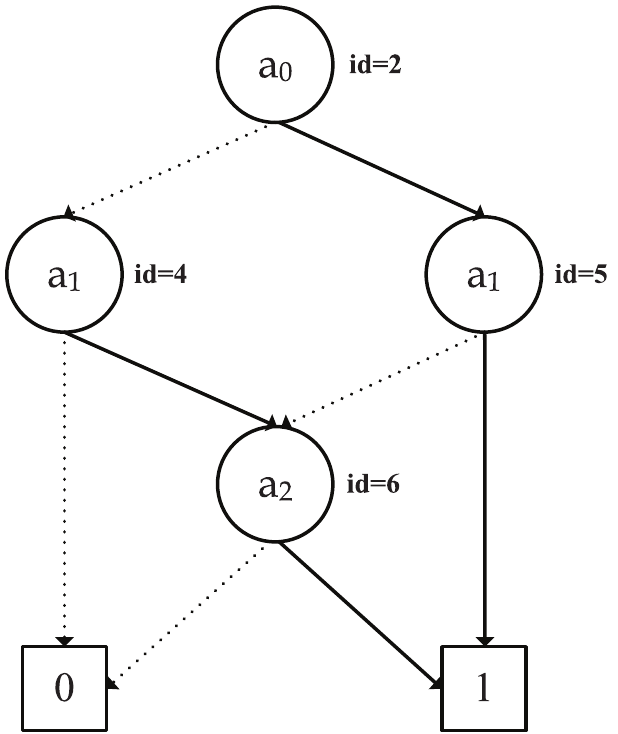
Fig 1. An OBDD access structure depicting the f ( a 0 , a 1 , a 2 ) = a 0 . a 1 + a 0 . a 2 + a 1 . a 2 access formula with variable ordering as: a 0 < a 1 < a 2 . The solid arrows represent the edges leading to the nodes’ high ( v ) child nodes and the dotted arrows represent the edges leading to the nodes’ low ( v ) child nodes.